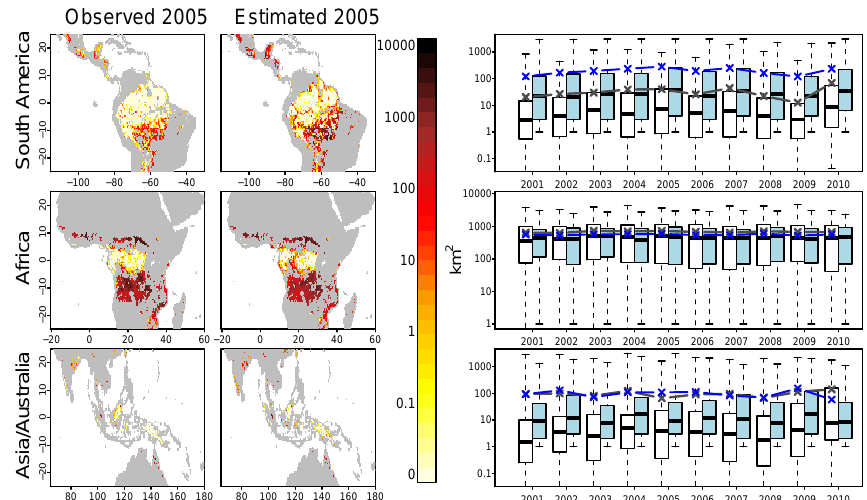
Fig. 7. Maps of the total observed (left) and estimated (middle) burnt areas for the tropical regions of South America, Africa and Asia/Australia in 2005, in hectares. The corresponding time series for these regions are shown on the right: the box plots illustrate the median burnt area values, interquartile ranges and full ranges of the annual, grid-cell observations (white/black) and estimates (blue), and the connected points show the mean annual grid-cell values.